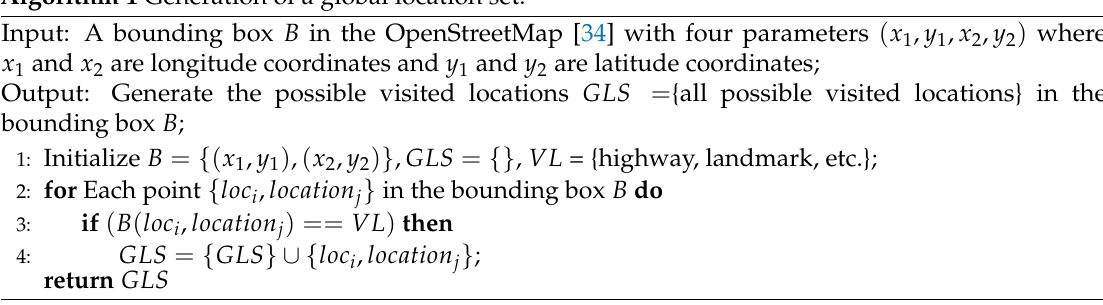
Algorithm 1 Generation of a global location